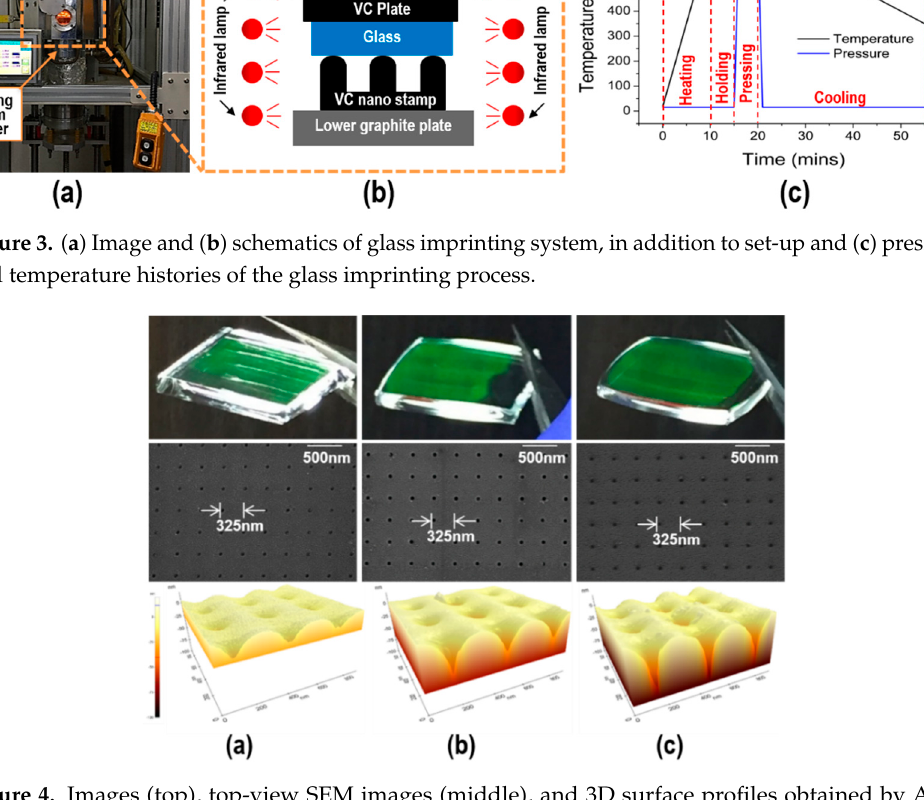
Figure 5. Comparison of cross-sectional surface profiles of glass imprinted cross-sinusoidal nanostructures at different imprinting temperatures.